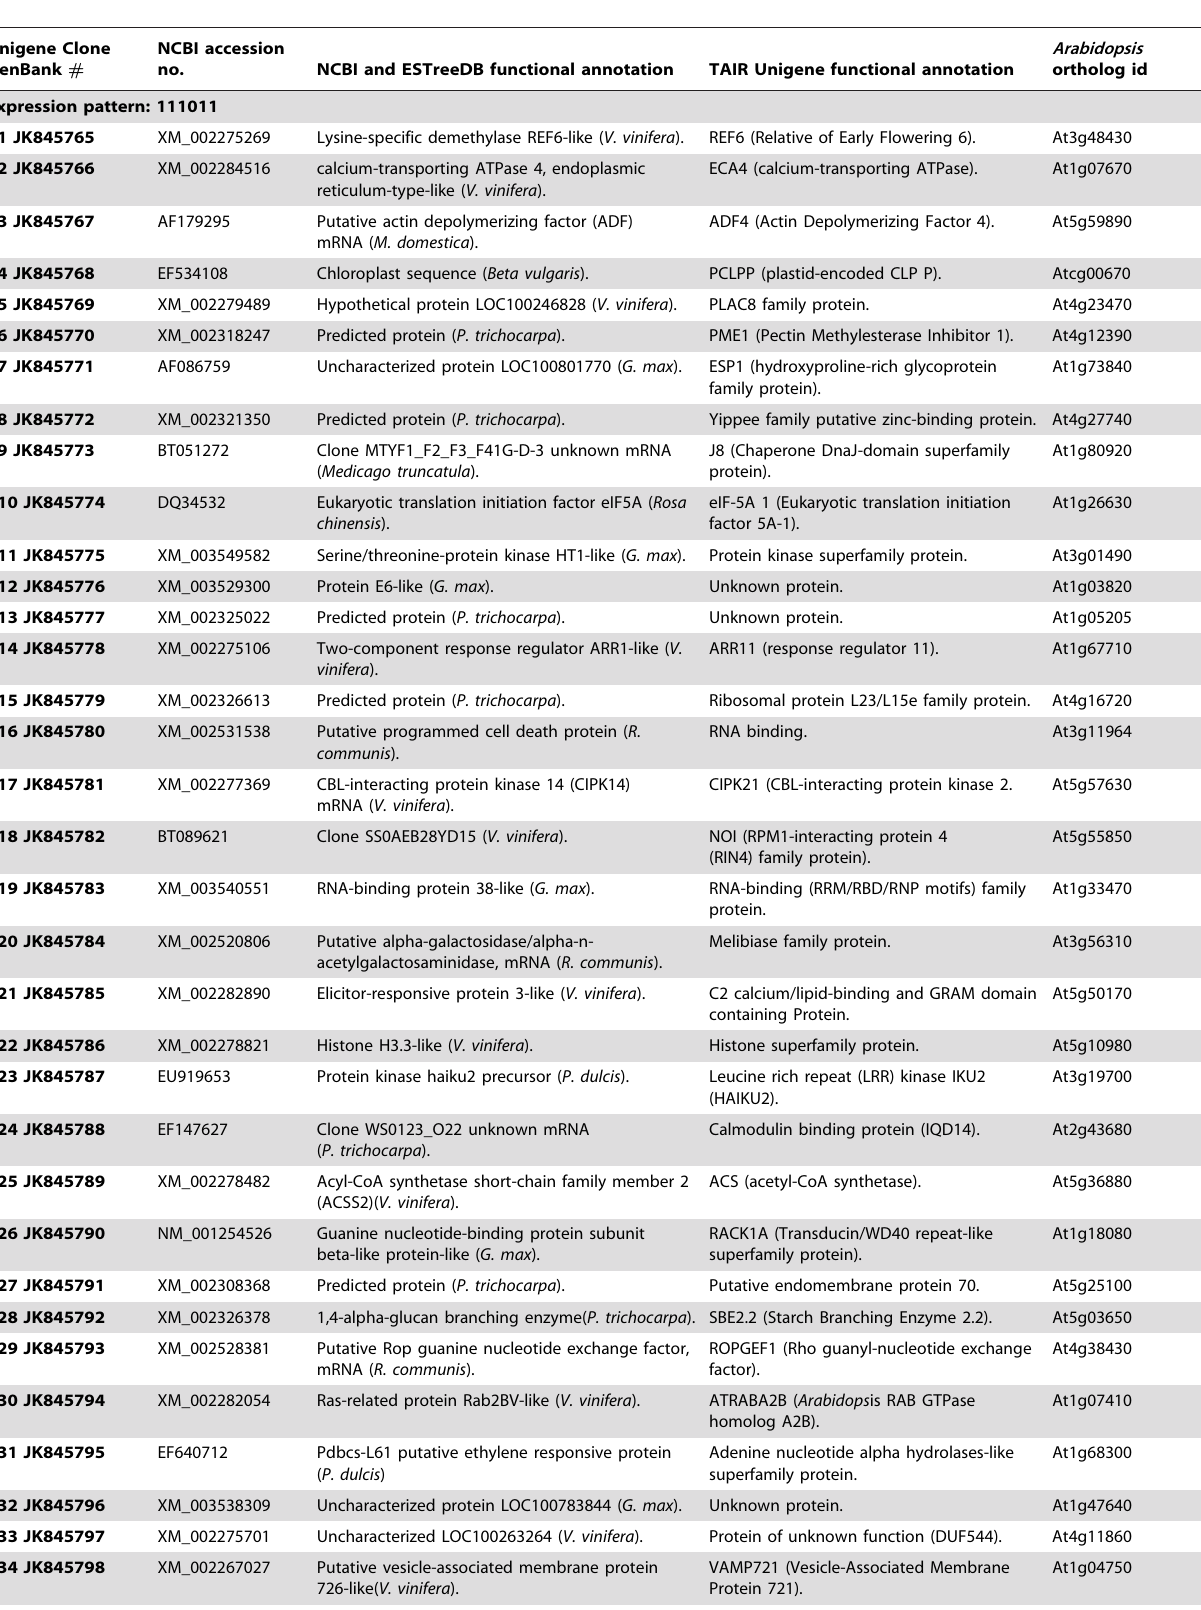
Table 3. Functional identity and gene ontology description of the isolated unigenes corresponding to the ‘‘Repressed Group’’ (RG)